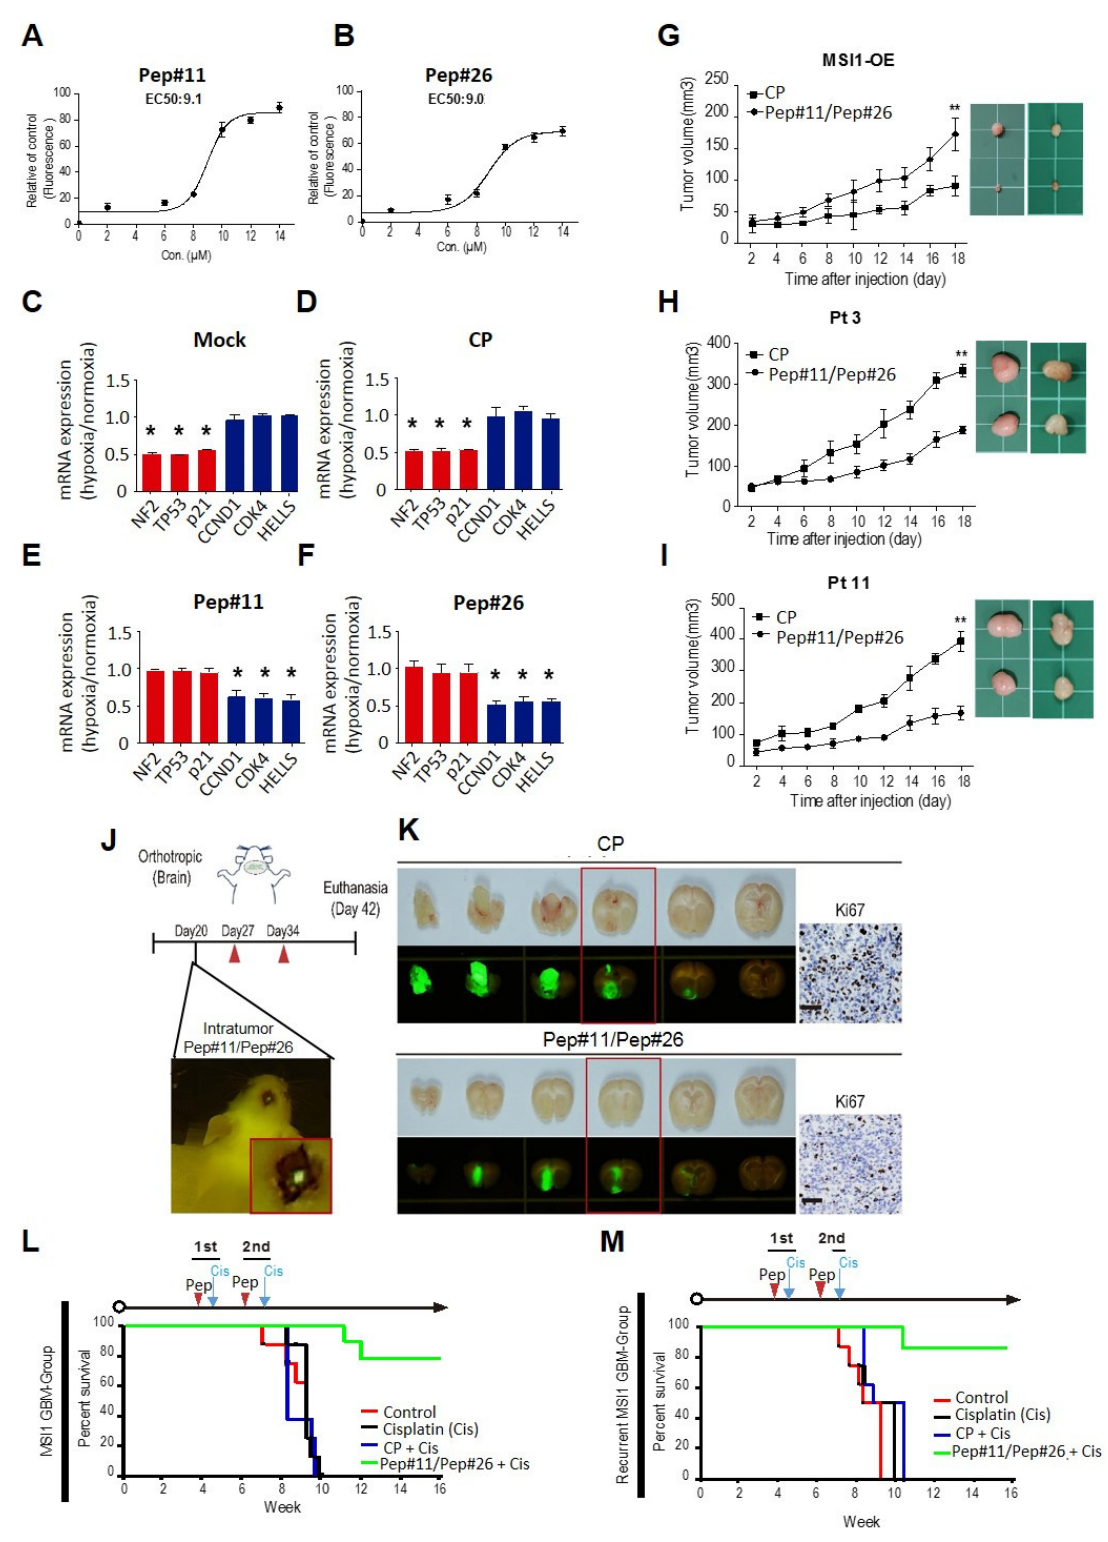
Figure 6. Cellular uptake efficiency and tumor suppression effects of Pep#11/Pep#26. ( A , B ) Cellular uptake curves for Pep#11 and Pep#26 peptides. The biological activity of peptides was tested in DBTRG-05MG cell line. The cells were treated with different concentrations of fluorescein labeled peptides and was measured using an ELISA reader. The half-uptake concentration (EC50) values of both peptides were 9.1 and 9.0 μ M/mL, respectively. ( C – F ) Cells transfected with control peptide